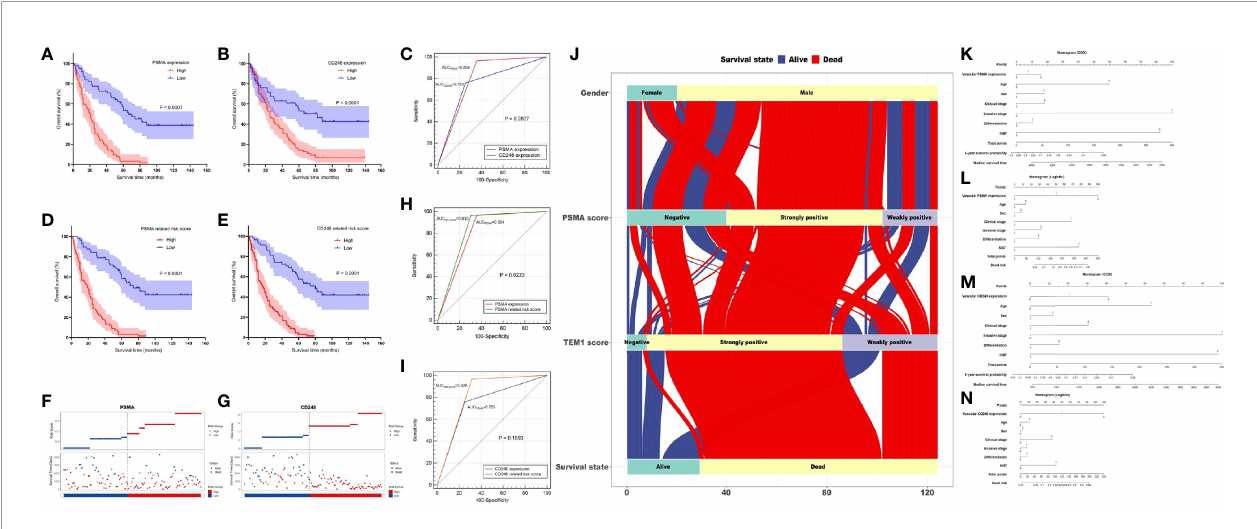
FIGURE 4 | Prognostic value of vascular CD248 and PSMA expression in UCB. (A, B) Kaplan – Meier survival curve showing the association between vascular PSMA (A) /CD248 (B) expression and overall survival of patients with UCB. (C) ROC curves for PSMA and CD248 expression. (D, E) Kaplan – Meier survival curve showing the association between (D) PSMA-/ (E) CD248-related risk score and overall survival of patients with UCB. (F, G) The distribution of the (F) PSMA-/ (G) CD248 - related risk score and the survival status of each patient. (H) ROC curves of PSMA expression and the PSMA-related risk score. (I) ROC curves of CD248 expression and the CD248-related risk score. (J) The fl ow direction of the fi nal outcome of patients with different expression levels of PSMA and CD248 in a Sankey plot. Nomogram of the vascular-PSMA-based signature for survival probability prediction (K) and risk of death prediction (L) . Nomogram of the vascular-CD248- based signature for survival probability prediction (M) and risk of death prediction (N)